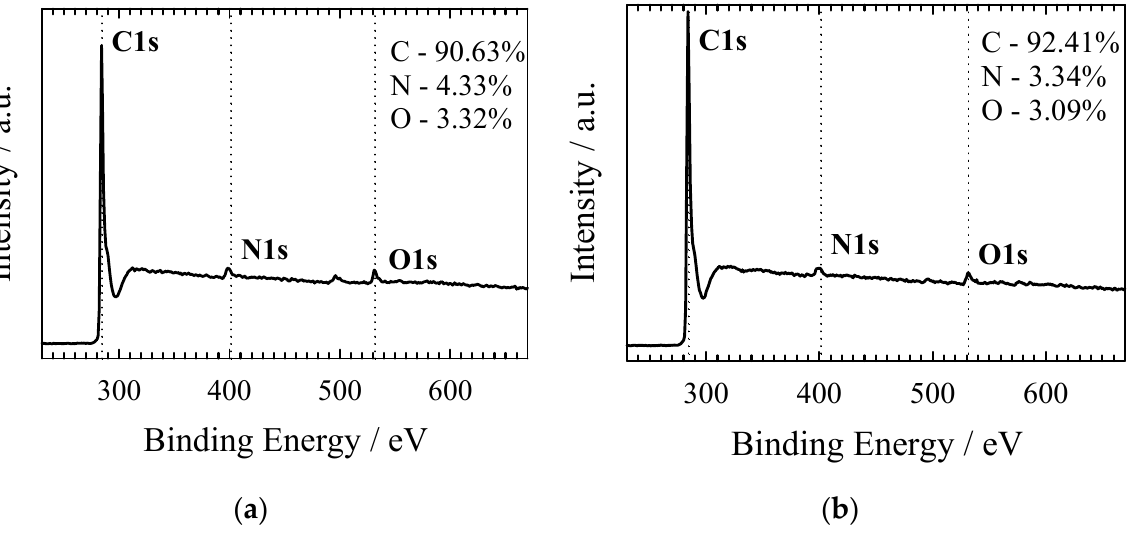
Figure 5. Survey spectra of NC-ABL ( a ) and NC-ABL-WC ( b ) carbons. The deconvoluted XPS spectra of C 1s, N 1s, and O 1s for NC-ABL and NC-ABL-WC carbon samples are shown in Figure 6.